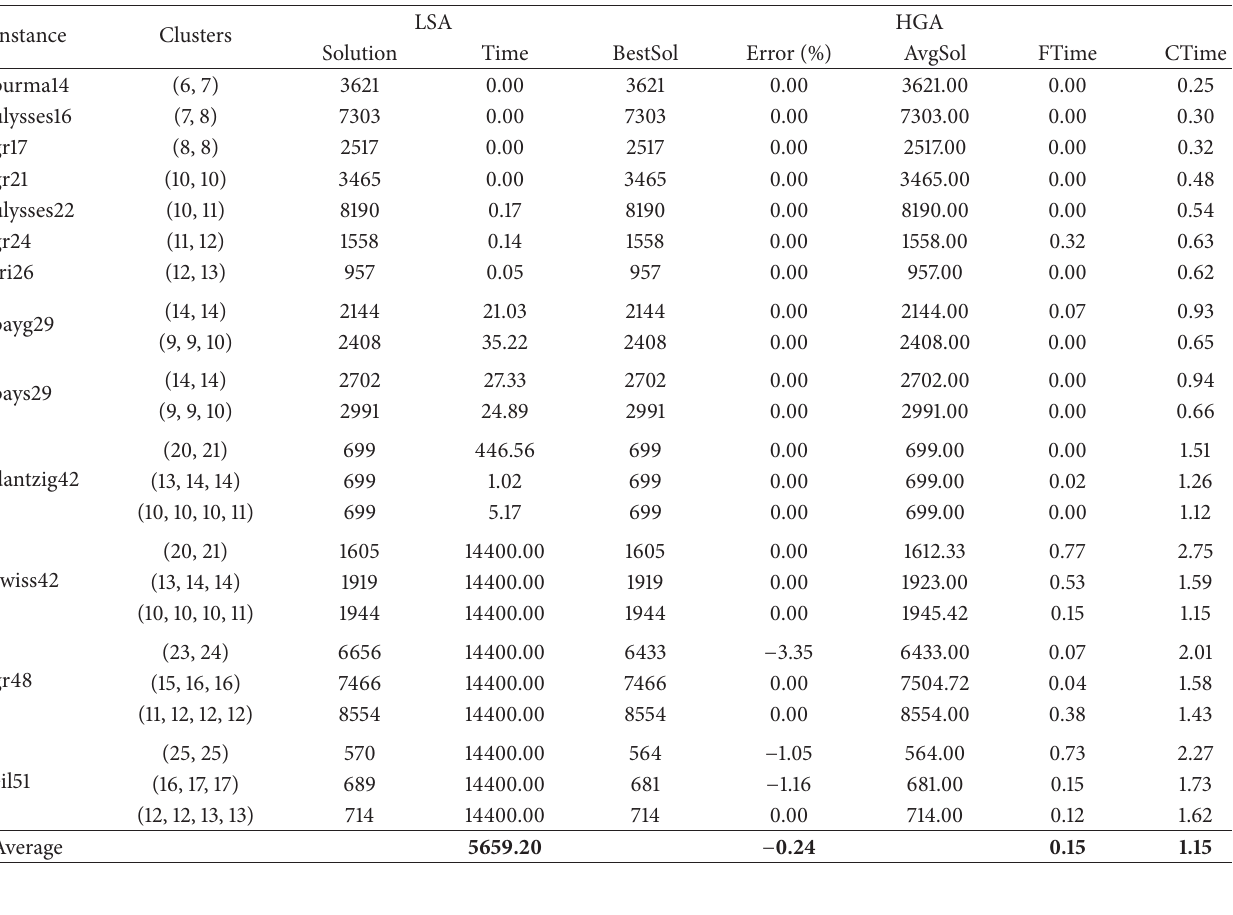
Table 6: A comparative study between LSA and HGA for symmetric TSPLIB instances.